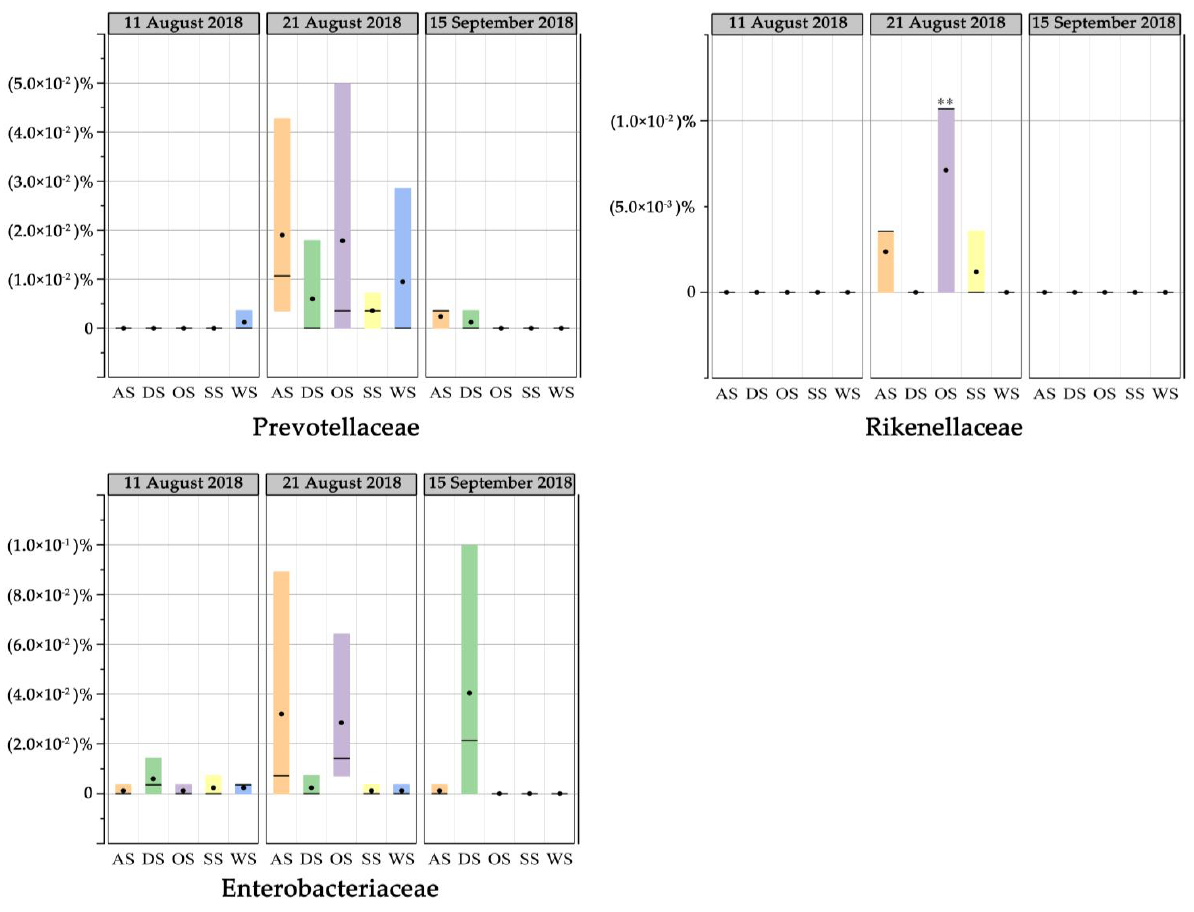
Figure 6. The percentage of sequences associated with human and other fecal taxa during the typhoon events in Jinshitan bathing beach.